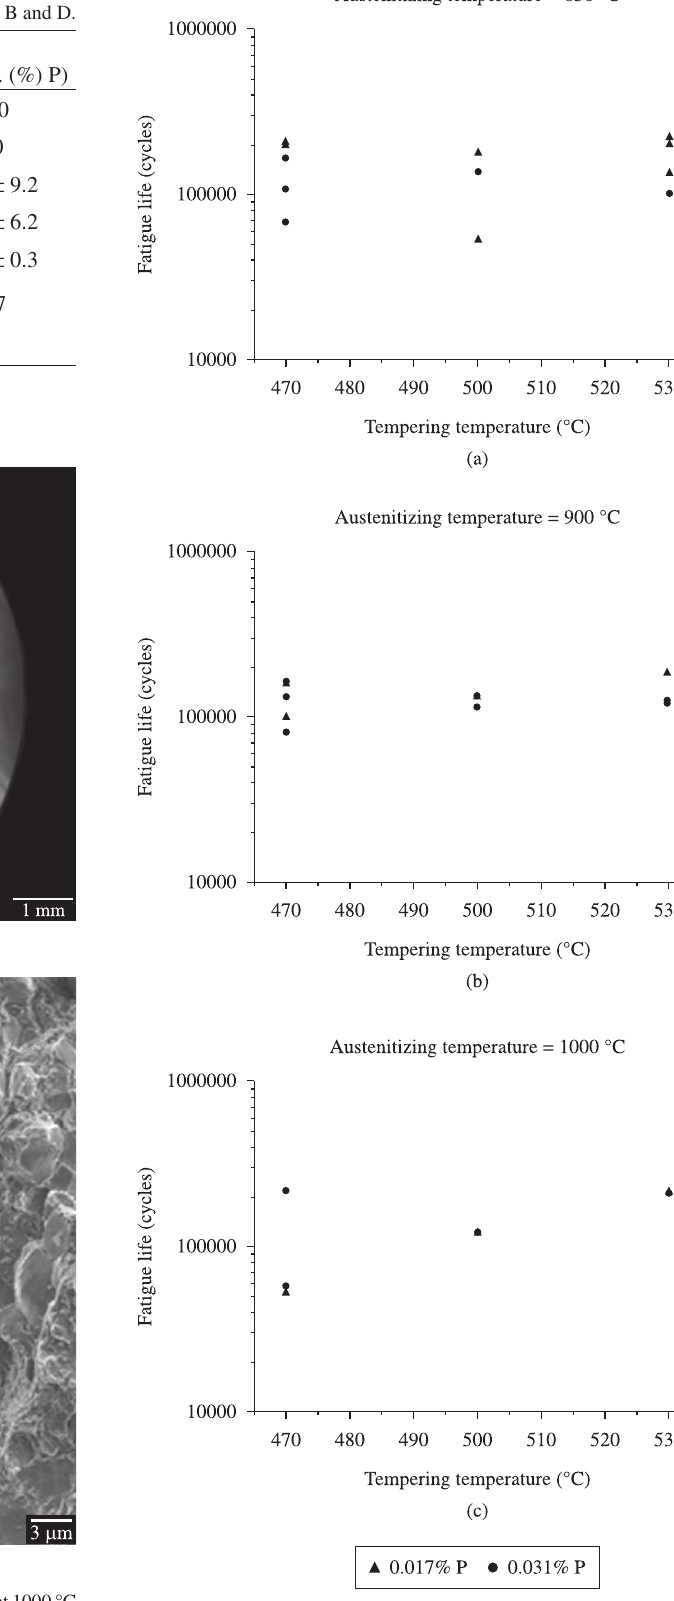
Figure 15. Fracture surface from steel D (0.031% of P) austenitized at 1000 °C and tempered at 470 °C: a) General view showing the notch, fatigue pre-crack and instable crack growth and b) Detail from the instable crack growth showing a brittle fracture